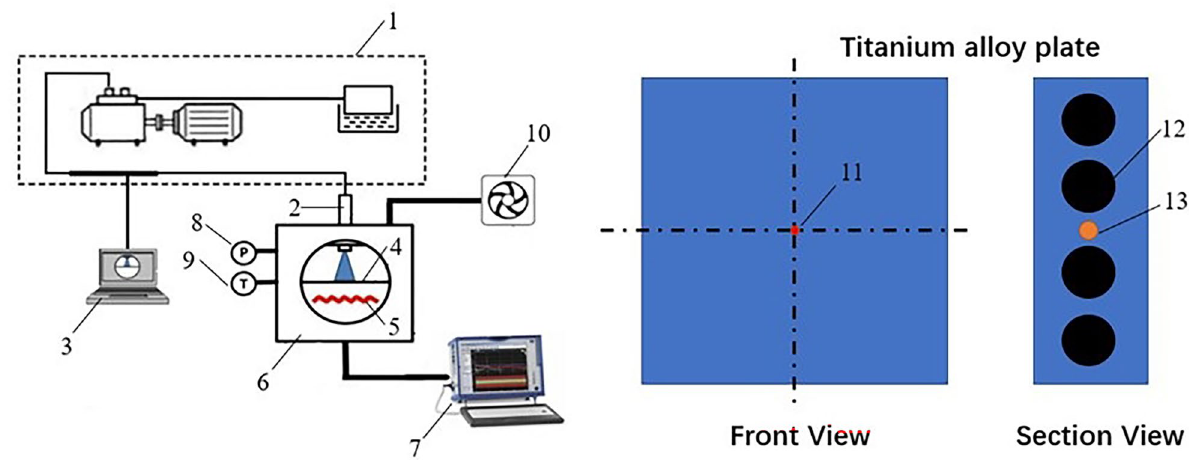
Figure 1. Schematic diagram of the spray-wall impingement test setup. (1-high-pressure common rail diesel injection system, 2-nozzle, 3-injector control system, 4-titanium alloy plate, 5-environmental heating system,